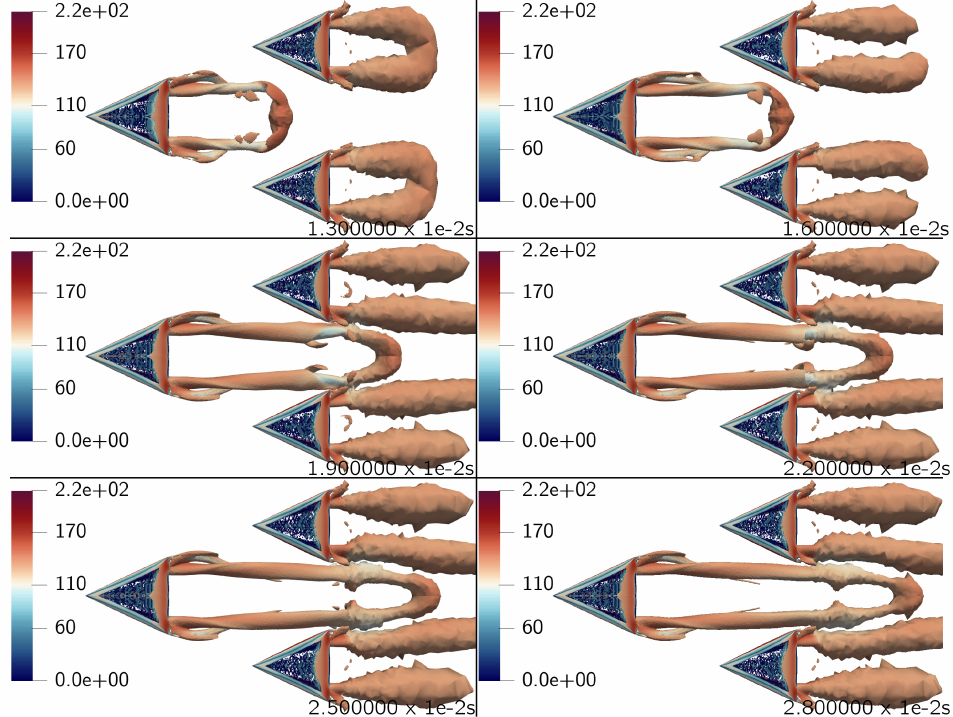
Figure 19. Contours of the Q-criterion Q = 800 s − 2 coloured with the velocity magnitude ( m / s ) for different time instants, formation flight test